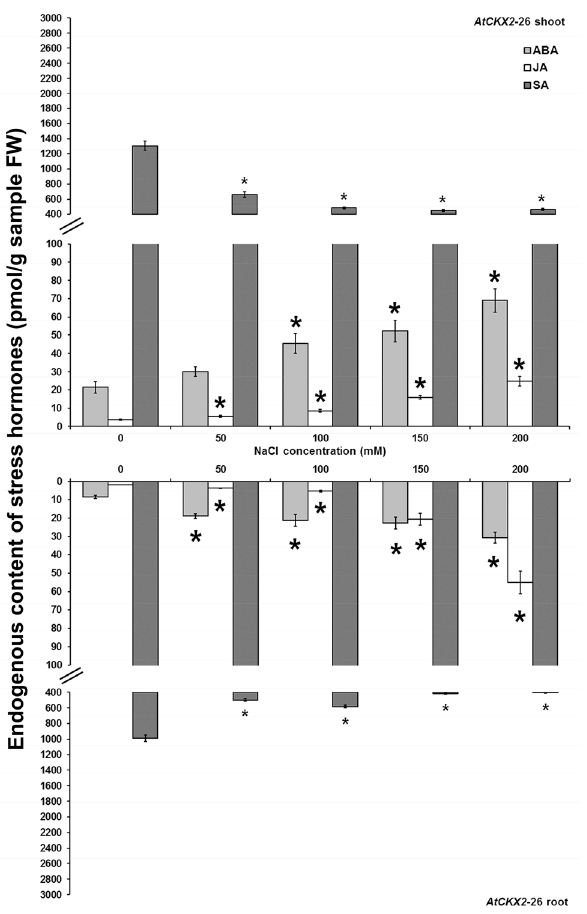
Figure 9. Endogenous ABA, JA and SA contents and in shoots and roots of 8-week-old AtCKX2 -26 transgenic Centaurium erythraea line. Data represent mean ± standard error. Means marked with asterisks are significantly different from corresponding control values (LSD test, p ≤ 0.05). The bigger asterisks represent the values significantly higher than control ones while smaller asterisks represent values significantly lower than control